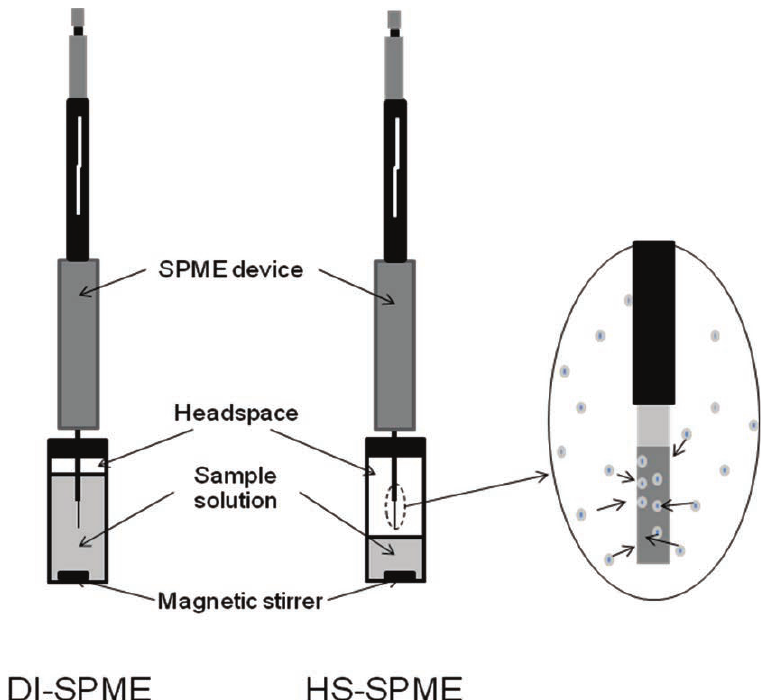
Figure 3. Schematic diagram of